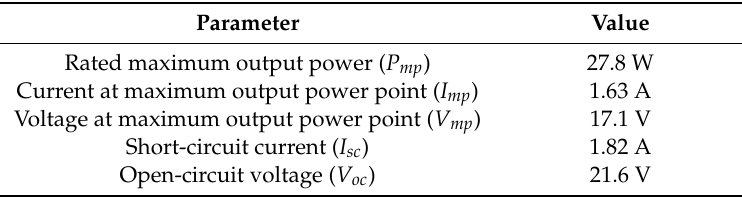
Table 3. Specifications of Sanyo HIP2717 Module.